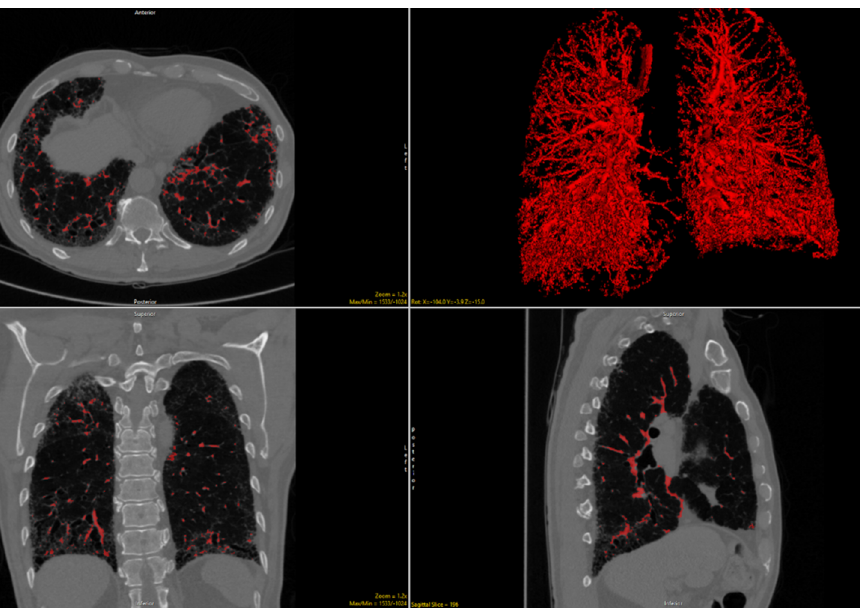
Figure 2. Delineation of volume-related structures on noncontract chest CT images and 3D recon- struction in a patient with connective tissue disease-related interstitial lung disease.